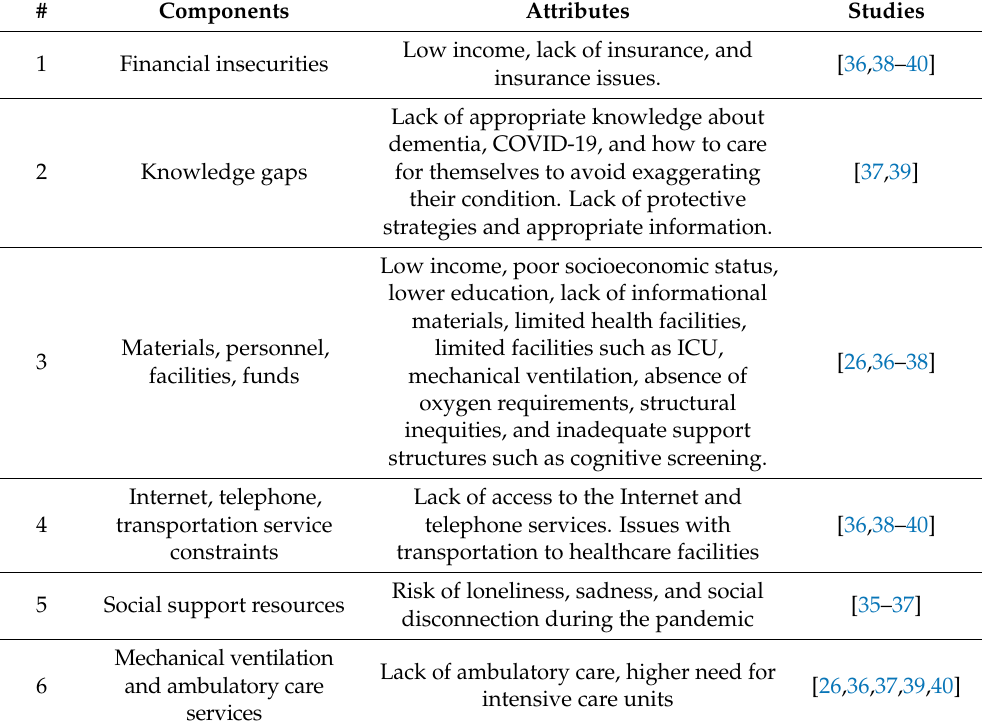
Table 4. Summary of evidence of resources to mitigate adverse outcomes in older African American adults with dementia and